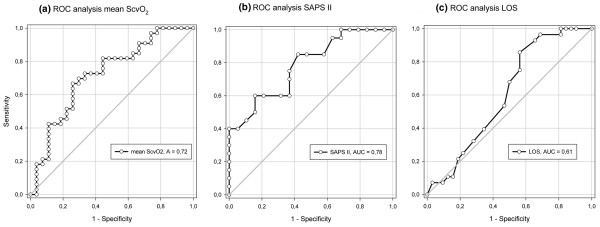
Receiver operator characteristic (ROC) analysis for (a) mean ScvO2, (b) SAPS II score, and (c) hospital length of stay (LOS). Outcome parameter for ROC analysis is occurrence of postoperative complications. Area under the curve (AUC) was 0.74 for mean ScvO2 (p = 0.004), 0.78 for SAPS II score (p = 0.002), and 0.61 for LOS (p = 0.15). SAPS II, simplified acute physiology score; ScvO2, central venous oxygen saturation.